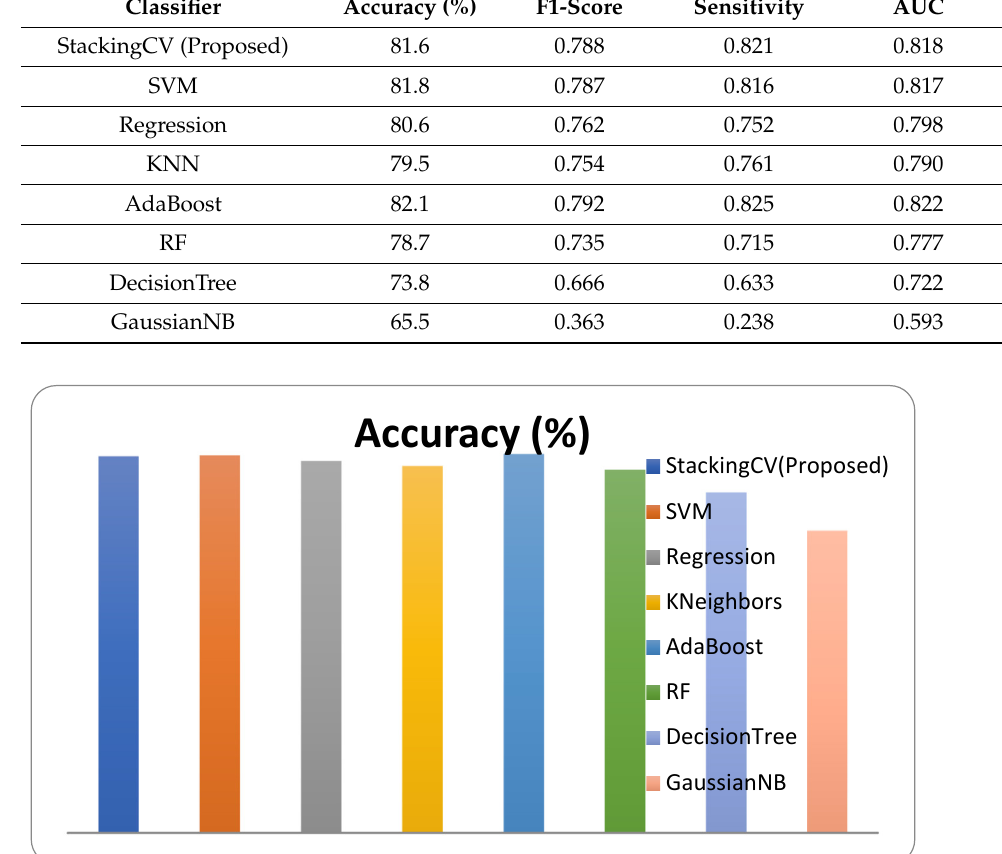
Figure 9. Performance of the system for Resnet50 features.